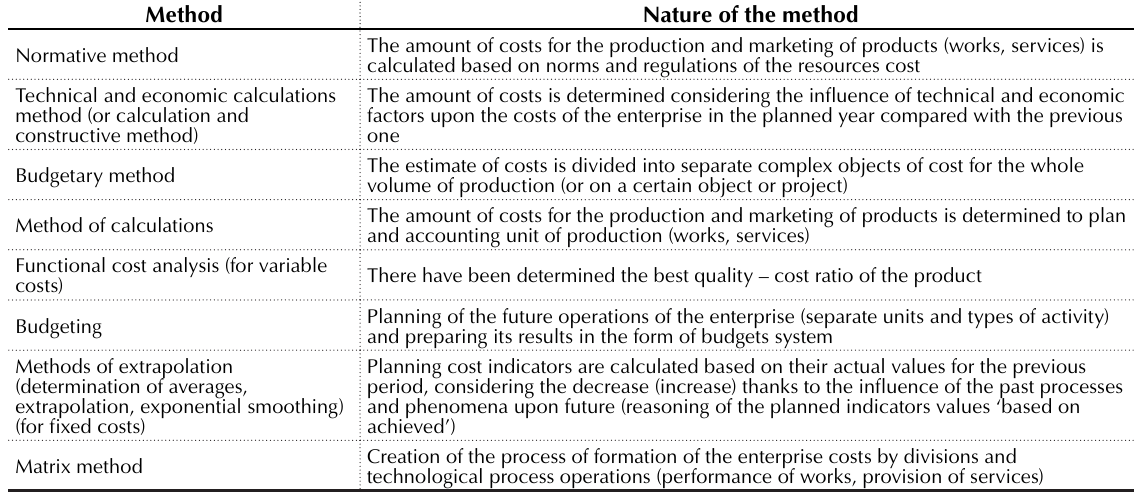
Table 3. The most common methods of costs planning at the enterprise